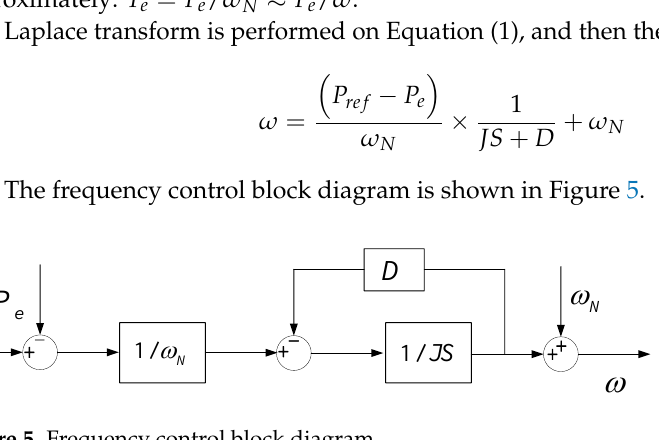
e Q r e f Q o U n U Figure 6. Voltage control block diagram. The VSG calculation process is as follows: the AC side collects the electric energy signal